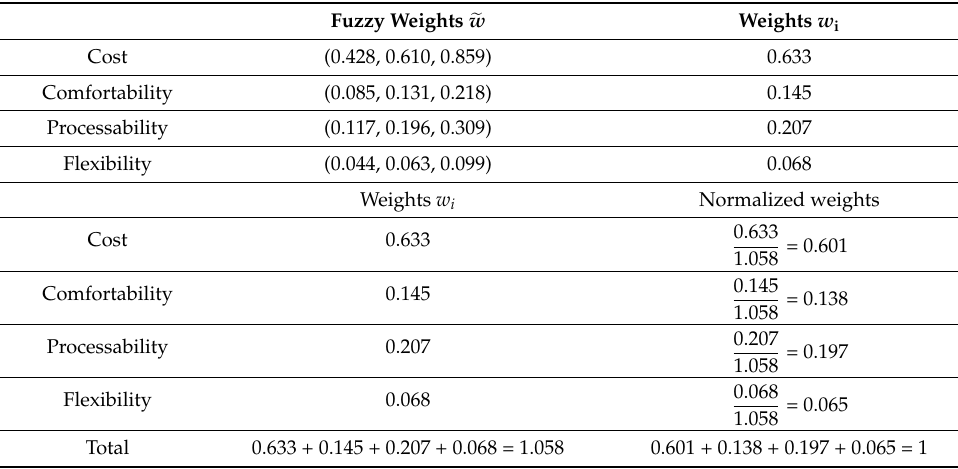
Table 8. Fuzzified pairwise comparison